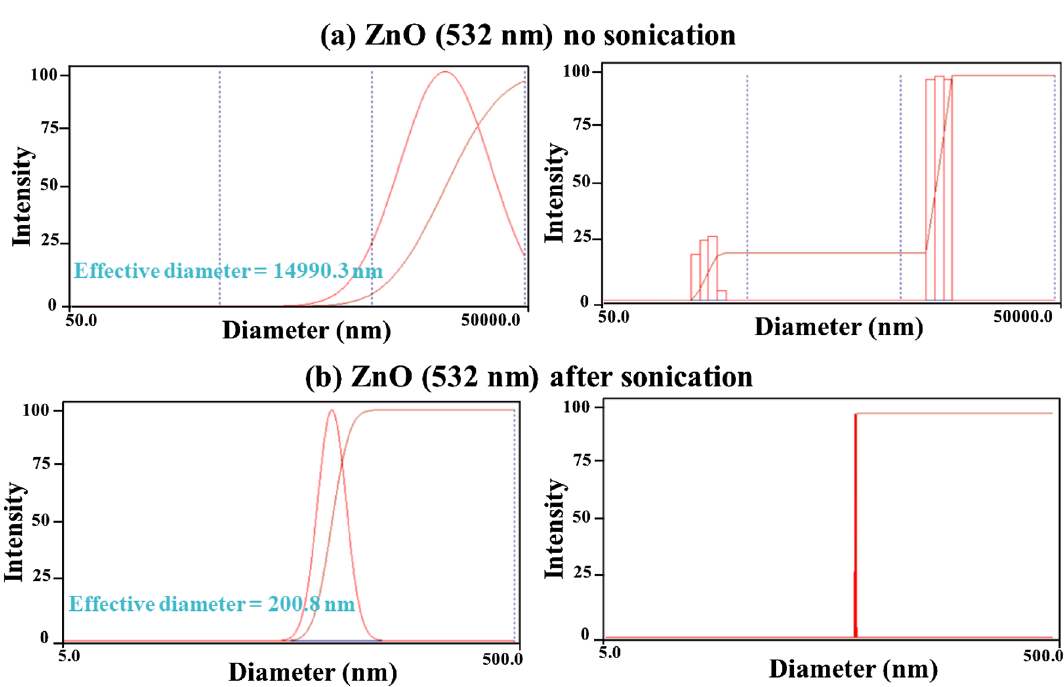
Figure 6. Results of the particle size distribution measurements after being irradiated with laser (532 nm) for the ZnO powder without and after specimen while other areas show the exposed substrate indicating the tendency of the NPs to agglomerate. The root means square roughness of the non-irradiated and the irradiated nanoparticles with 1064 nm and 532 nm lasers are 218 nm , 263 nm and 316 nm respectively. The average roughness is 170 nm , 193 nm , and 227 nm for the non-irradiated and irradiated nanoparticles respectively (i.e. an increase of average roughness with the energy of the laser beam). This might be attributed to the effect of laser on the agglomeration nature of the NPs. This